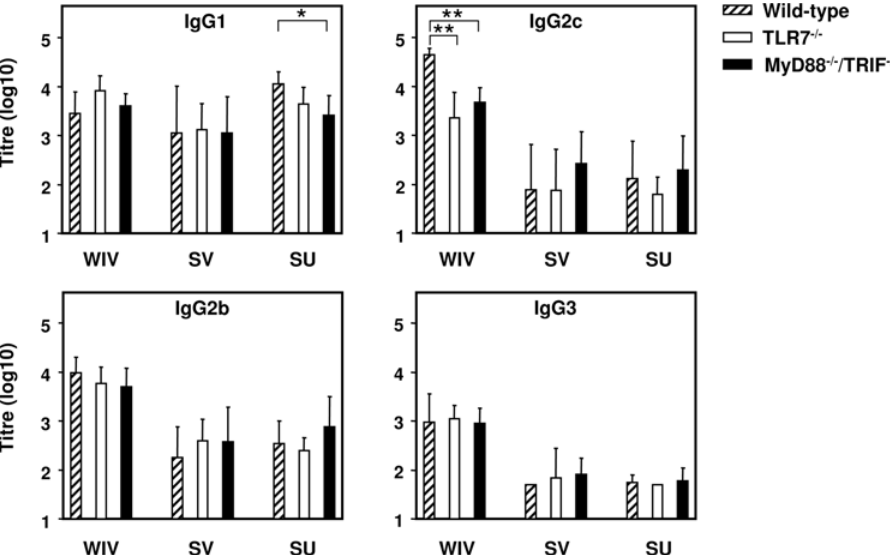
Figure 3. H5N1 WIV vaccine induces Th1-type antibody responses via TLR7 signalling. Serum titres of H5N1-specific IgG1 subtype (Th2- type antibody), and IgG2c, IgG2b, and IgG3 subtypes (Th1-type antibodies) were determined by ELISA. Geometric mean titres are plotted for each group of wild-type mice or mutant mice (n=8; MyD88 2 / 2 /TRIF 2 / 2 /SU, n=7) immunized with WIV, SV, or SU vaccine. Significant ( p , 0.05) and highly significant ( p , 0.01) differences between wild-type mice and mutant mice receiving the same vaccine are indicated by * and **, respectively.